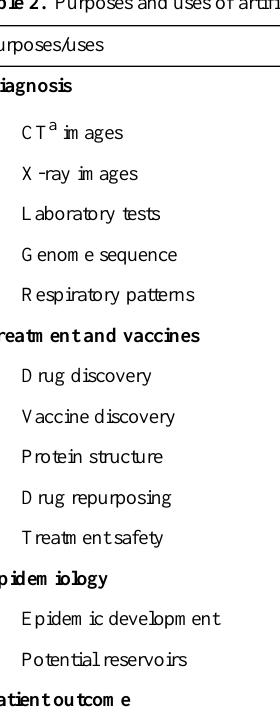
Table 2. Purposes and uses of artificial intelligence against COVID-19.